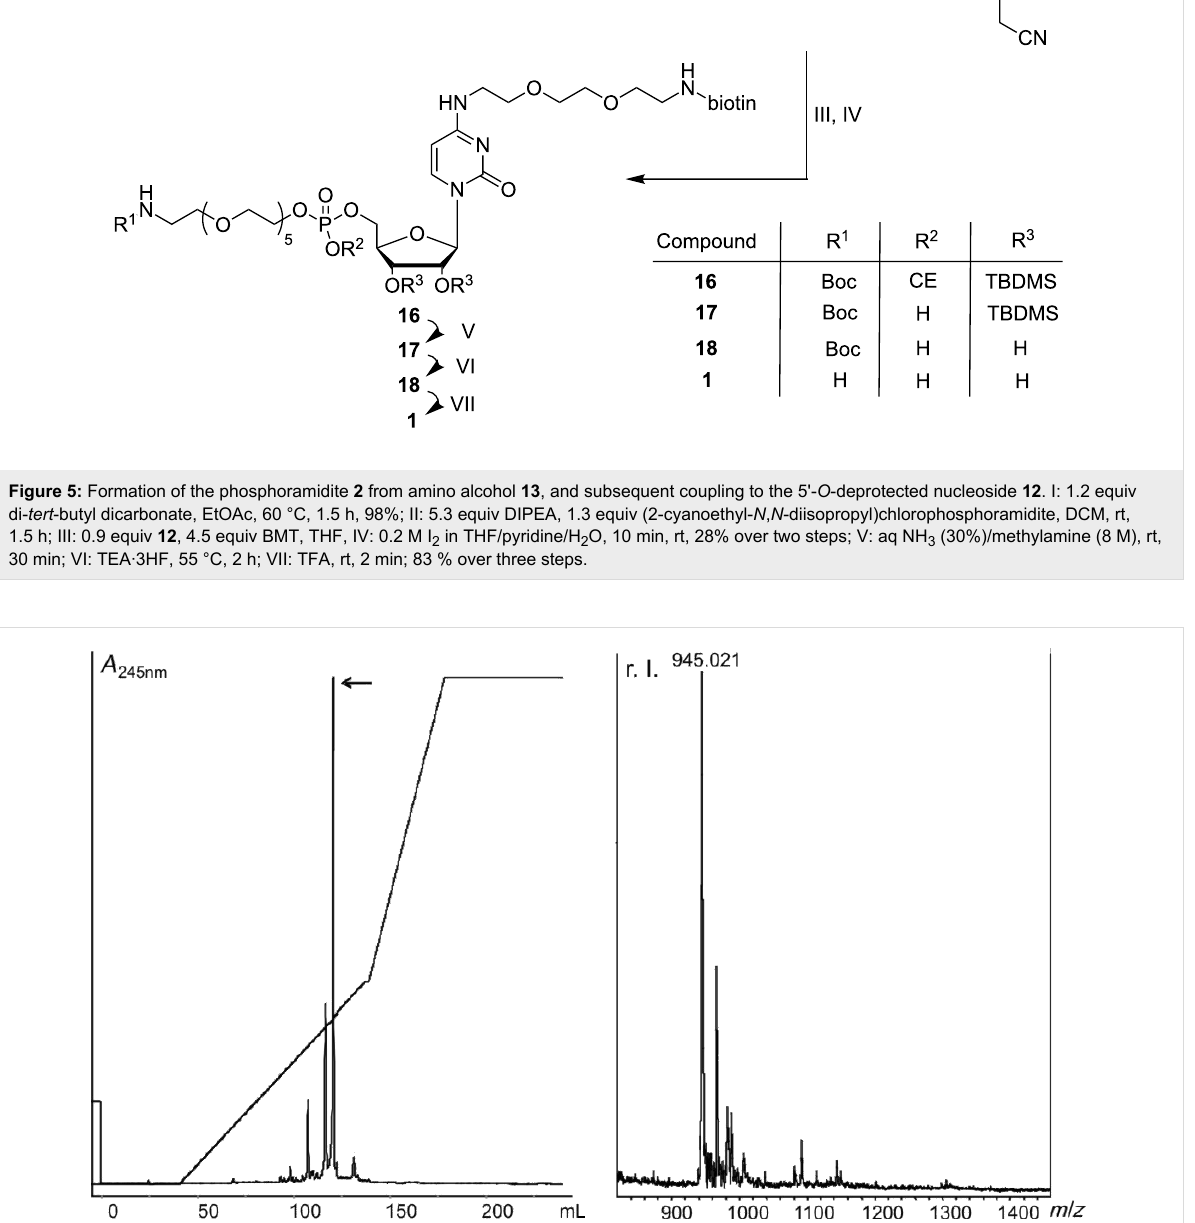
cyanoborohydride reduced RNA (C), peak II corresponding to the cytidine derivative 1 (B), and a new peak (III) indicating the desired RNA–cytidine conjugate, as confirmed by MALDI mass spectrometry (see Supporting Information File